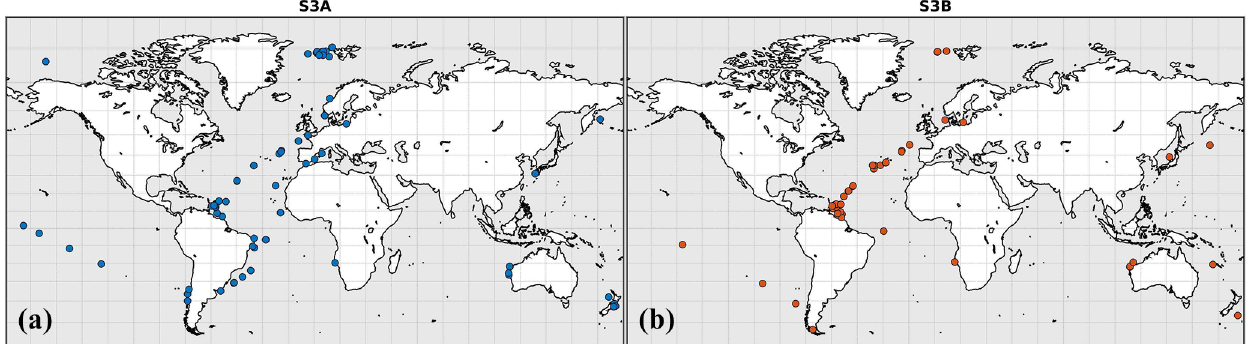
Figure 25. Collocations of S3A (a) and S3B (b) with MAN for January 2020–September 2021.